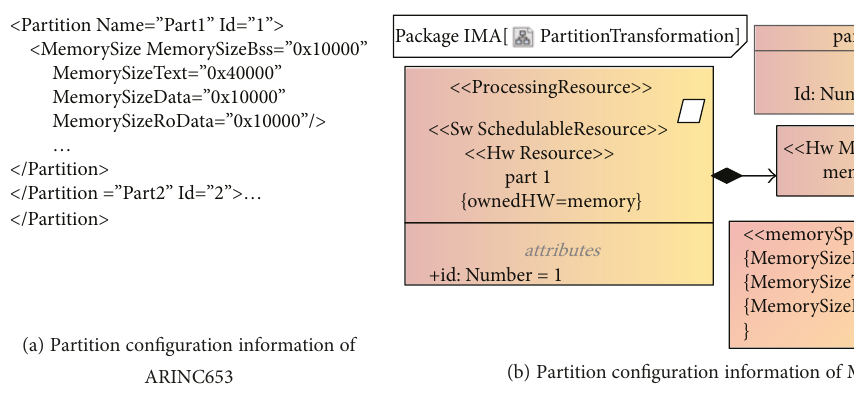
Figure 4: Partition con fi guration transformation from ARINC653 to MARTE. Table 4: Process transformation rule. ARINC653